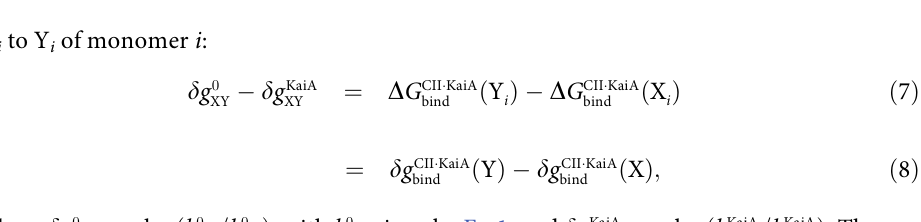
Ordered phosphorylation of the S and T sites due to phosphotransfer dynamics, nucleo- tide exchange and differential affinity. It is well known that the S and T sites in each